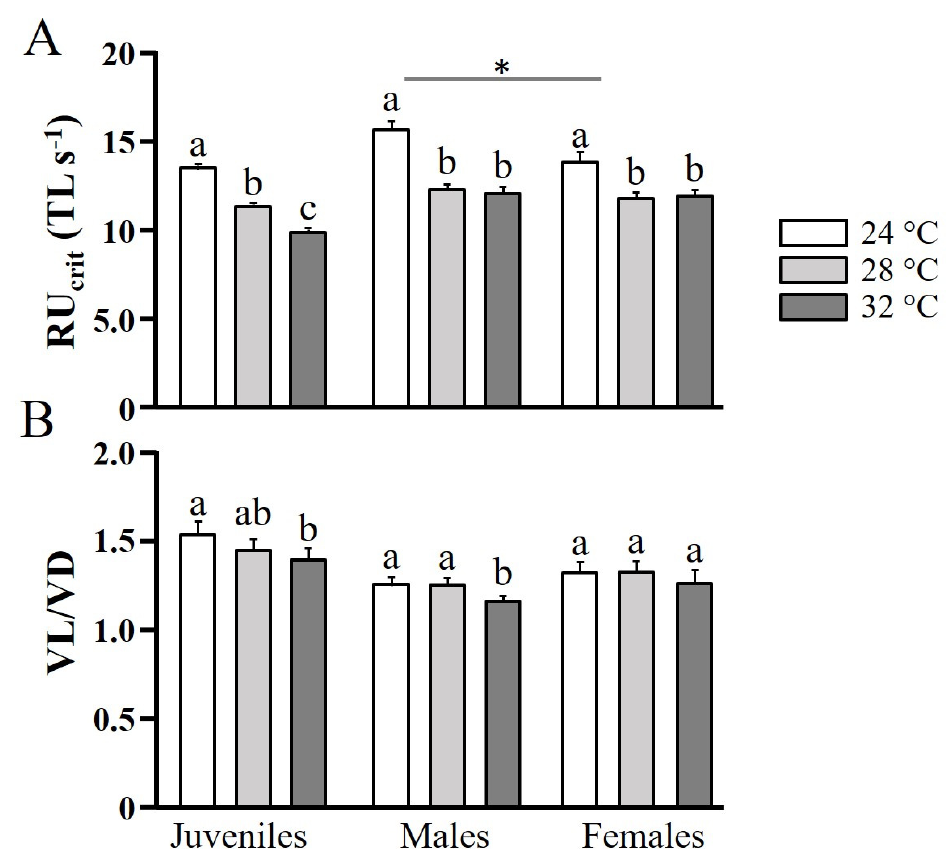
Figure 2. Effect of embryonic temperature on ( A ) the aerobic swimming capacity of zebrafish juveniles ( n = 21–29), males ( n = 21–27) and females ( n = 15–20) and on ( B ) juvenile and adult cardiac anatomy. Ventricle length-to-depth ratio in juveniles ( n = 14–16), males ( n = 6 in all groups) and females ( n = 5–7) for the different thermal treatments. Asterisks represent significant statistical differences between females and males of the same thermal treatment ( p < 0.05, Mann–Whitney U test). Values without a letter in common are statistically different ( p < 0.05, Kruskal–Wallis and Mann–Whitney U test. Error bars equal to 1 SEM (Standard Error of